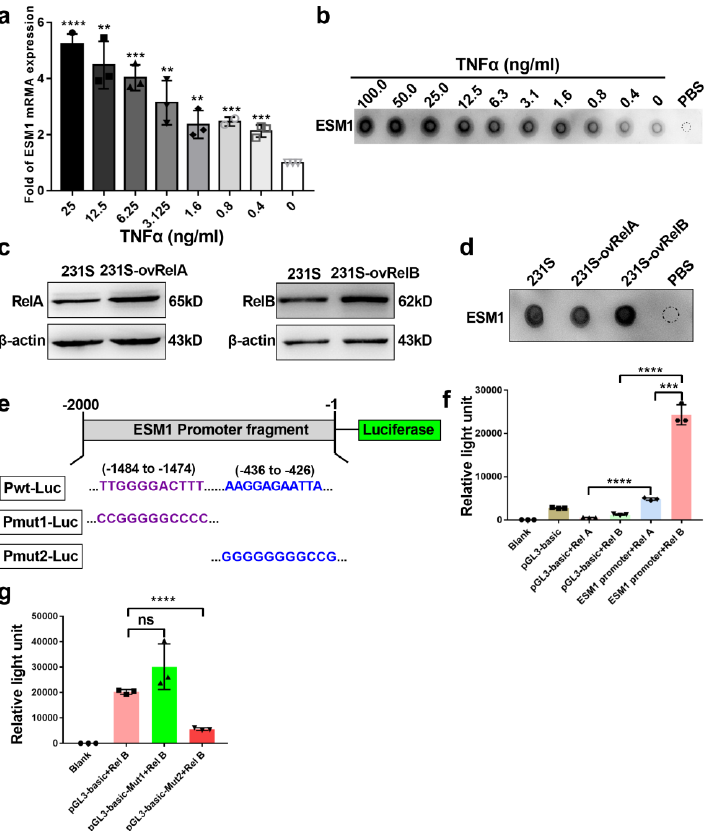
Figure 4. ESM1 is regulated by TNF α through RelB subunit of NF- κ B. ( a ) qRT-PCR of ESM1 levels in MDA-MB-231-S tumor cells treated with various concentrations of TNF α (ng/mL). 0 ng/mL TNF α treated group as control, ** p < 0.01; *** p < 0.001, by t test. ( b ) Dot blotting of ESM1 in MDA-MB-231-S tumor cells supernatant under various concentrations of TNF α (ng/mL) treatment. ( c ) RelA or RelB was overexpressed in MDA-MB-231-S cells and detected by western blotting (Figure S2). ( d ) Dot blotting of ESM1 in MDA-MB-231-S tumor cells supernatant after overexpressed RelA or RelB, dot indicated plasmids for 24 h, luciferase activity was determined, *** p < 0.001; **** p < 0.0001, by t